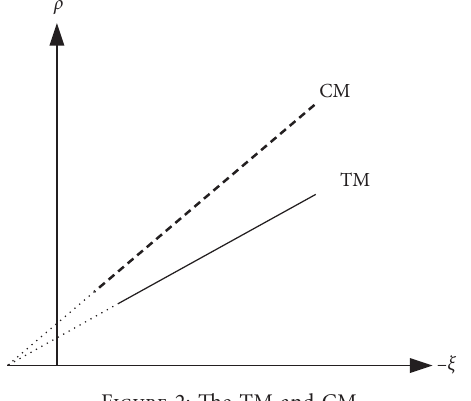
Figure 2: The TM and